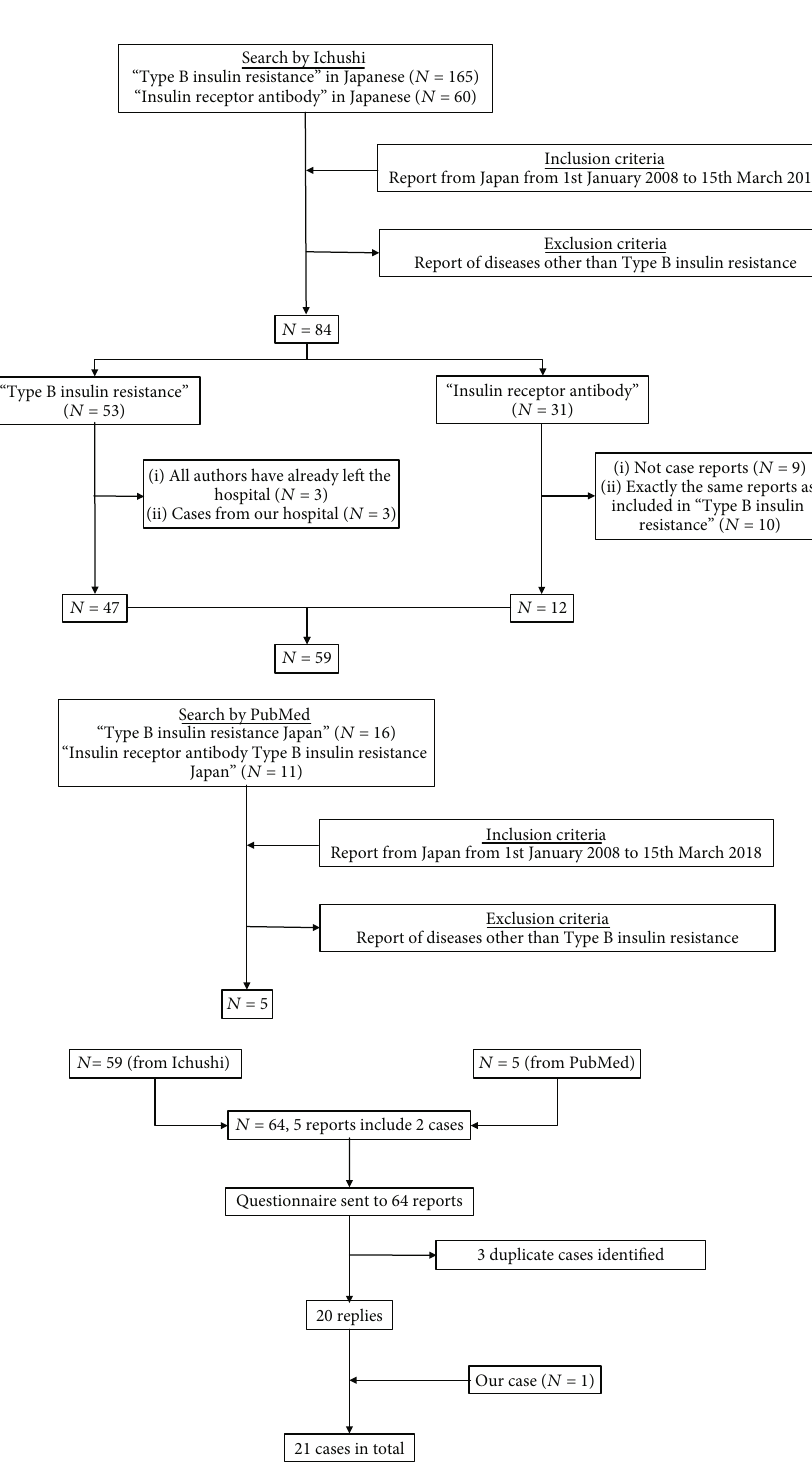
Figure 1: Flow chart showing the selection of study